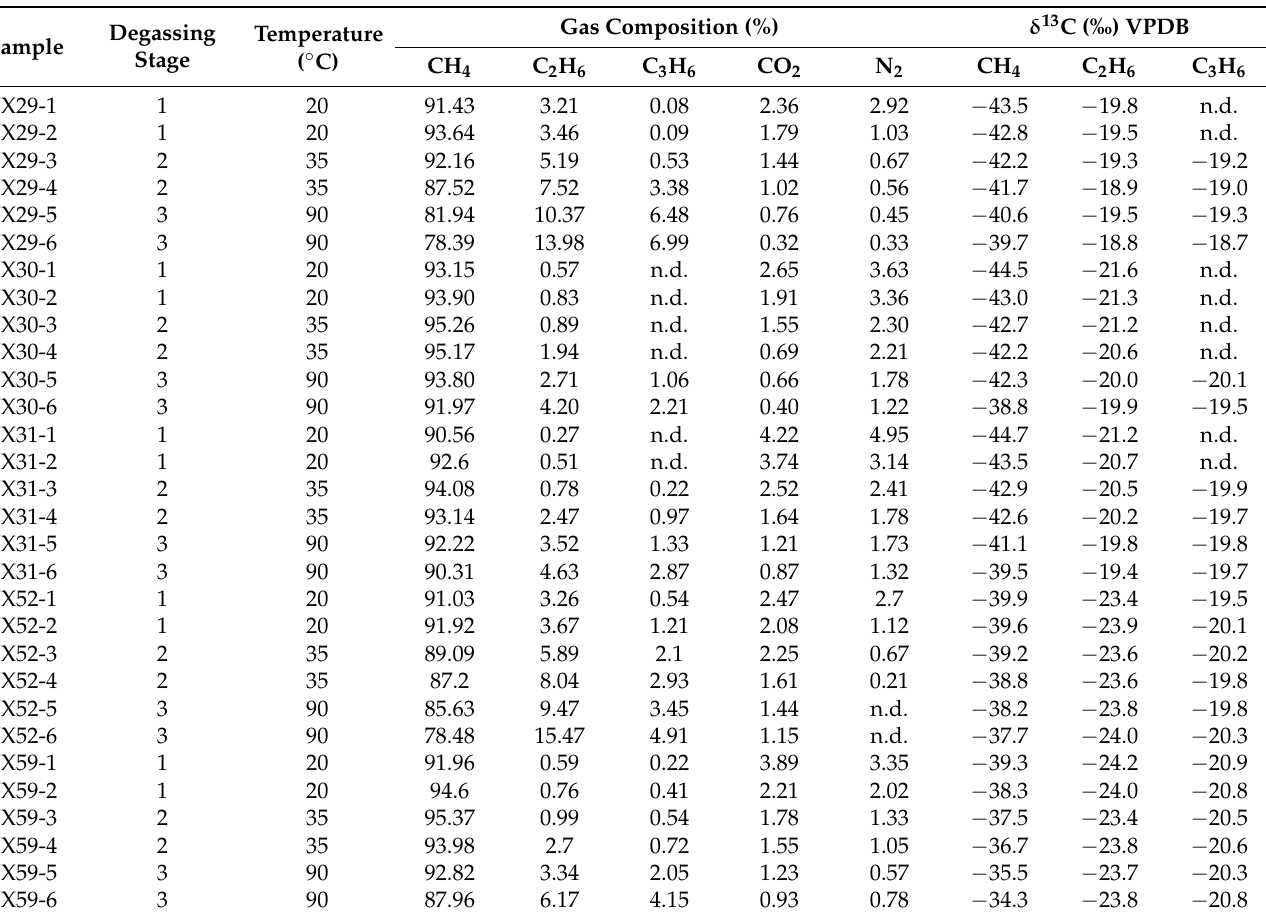
Table 1. Molecular and carbon isotopic data of gases released in canister degassing of shale samples in well ZY-1. n.d. means not detected.